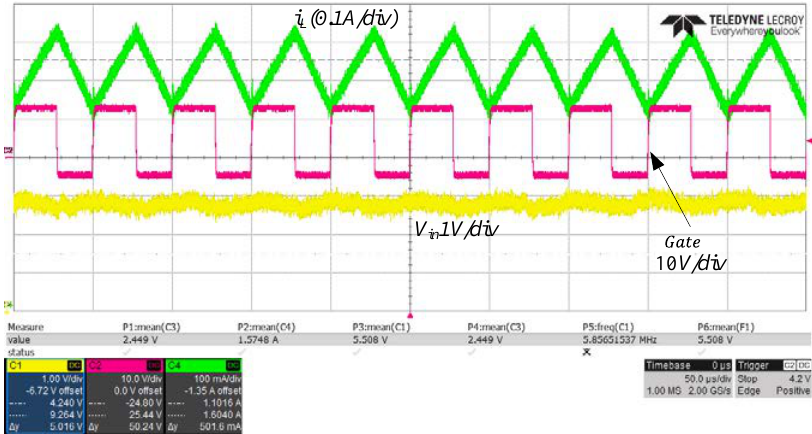
Figure 11. Experimental waveforms for the current, PWM signal, and input voltage of the operating boost converter. Energies 2018 , 11 , x 13 of 17